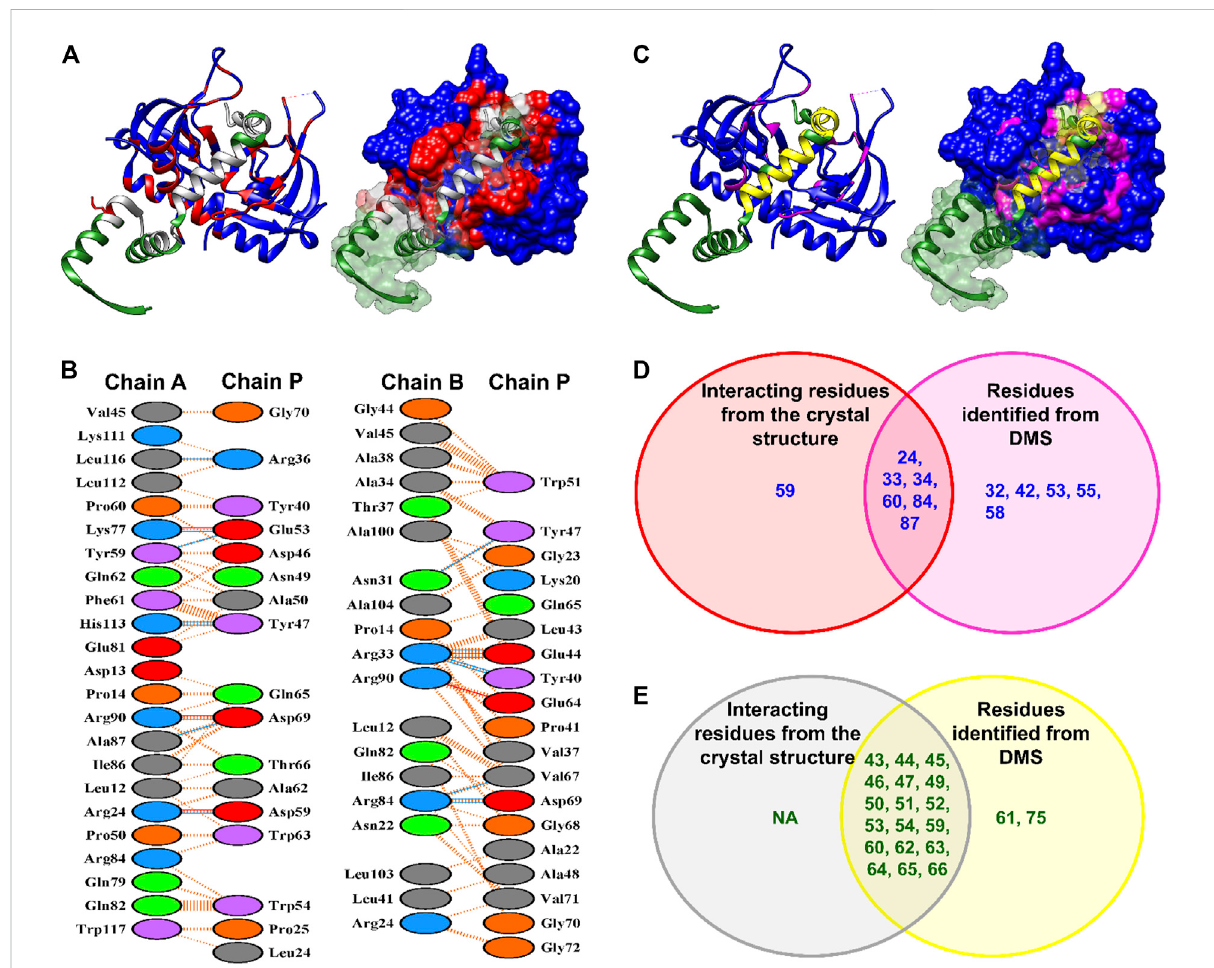
FIGURE 6 Comparisonbetweeninterfaceresiduesidenti fi edfromthecrystalstructureandinferredfromdeepsequencingdatafortheMazEF9system. (A) Theleftpanelshows theinterfaceresiduesdeterminedfromtheMazEF9crystalstructure.ThetoxinMazF6andantitoxinMazE6arecolouredinblue and green respectively. The surfacerepresentation ofthesame isshown intherightpanel. Theinteracting residues are shown inredfor MazF9toxin and in grey for MazE9 antitoxin. Only one monomer of the antitoxin is shown for clarity. (B) PDBsum identi fi ed interacting residues in MazEF9 structure depicted in Figure (A) . Toxin chains (A,B) are each joined by coloured lines to the antitoxin chain (P). Each colour represents a different type of interaction (Salt bridge-Red; Hydrogen bonds-Blue; Non-bonded contacts-Orange (C) The left panel shows the experimentally inferred residues from DMS libraries which are highlighted in magenta for MazF9 toxin and yellow for MazE9 antitoxin on the MazEF9 crystal structure. The surface representation of the same is shown in the right panel. (D – E) Venn diagram showing the overlap between the interacting residues deciphered from the MazEF9 crystal structure (in red and grey circles) and experimentally veri fi ed mutants (in magenta and yellow circles) for (D) MazF9(blue)and (E) MazE9(green).OnlyresidueswhichwerereliablyrepresentedintheDMSlibraryafterpassing thereadcriteria,areshown in the Venn diagram. ‘ NA ’ indicates no interacting residues. The seven residues (two from MazE9 library and fi ve from MazF9 library) which